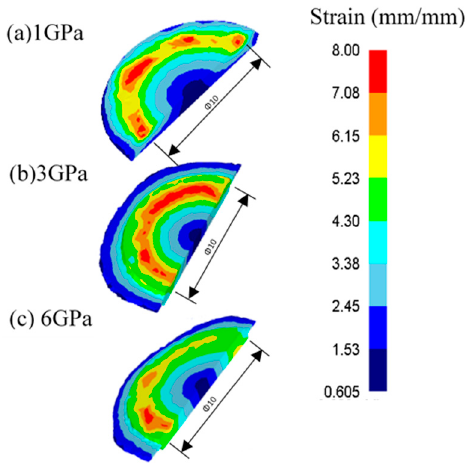
Figure 3. Distribution of strain on the half-disc surfaces and along the disc longitudinal sections of samples after a 1/2 turn with ( a ) 1 GPa; ( b ) 3 GPa; and ( c ) 6 GPa.